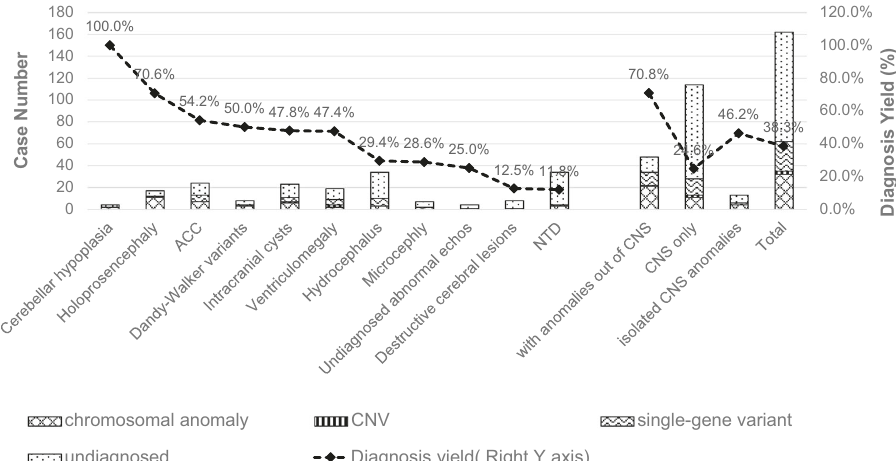
Fig. 1 Diagnostic yields of WGS in different types of CNS anomalies and distribution of diagnostic variants. Bars indicate case numbers (left y-axis) and the dashed line shows the diagnostic rate (%) (right y-axis). Cases were repeatedly counted if more than one sonographic feature was presented. Isolated brain anomalies only included aplasia of the corpus callosum, arachnoid cyst, and ventriculomegaly, as other CNS anomalies are usually complex and involve several anatomical structures of the brain. ACC aplasia of corpus (determined from survey data from the National Bureau of Statistics of China) 12 . The chromosomal sex ratio of the fetuses